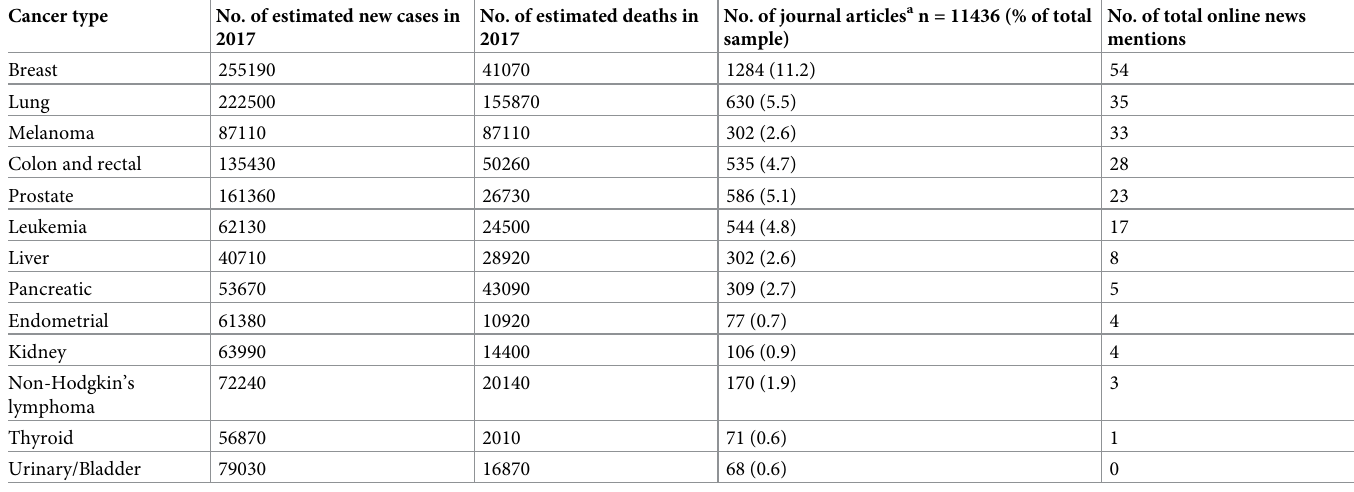
Table 2. Common cancer types covered by journal articles in 2016 resulting from US government funds in relation to news and mass media mentions, number of estimated new cases in 2017 and estimated